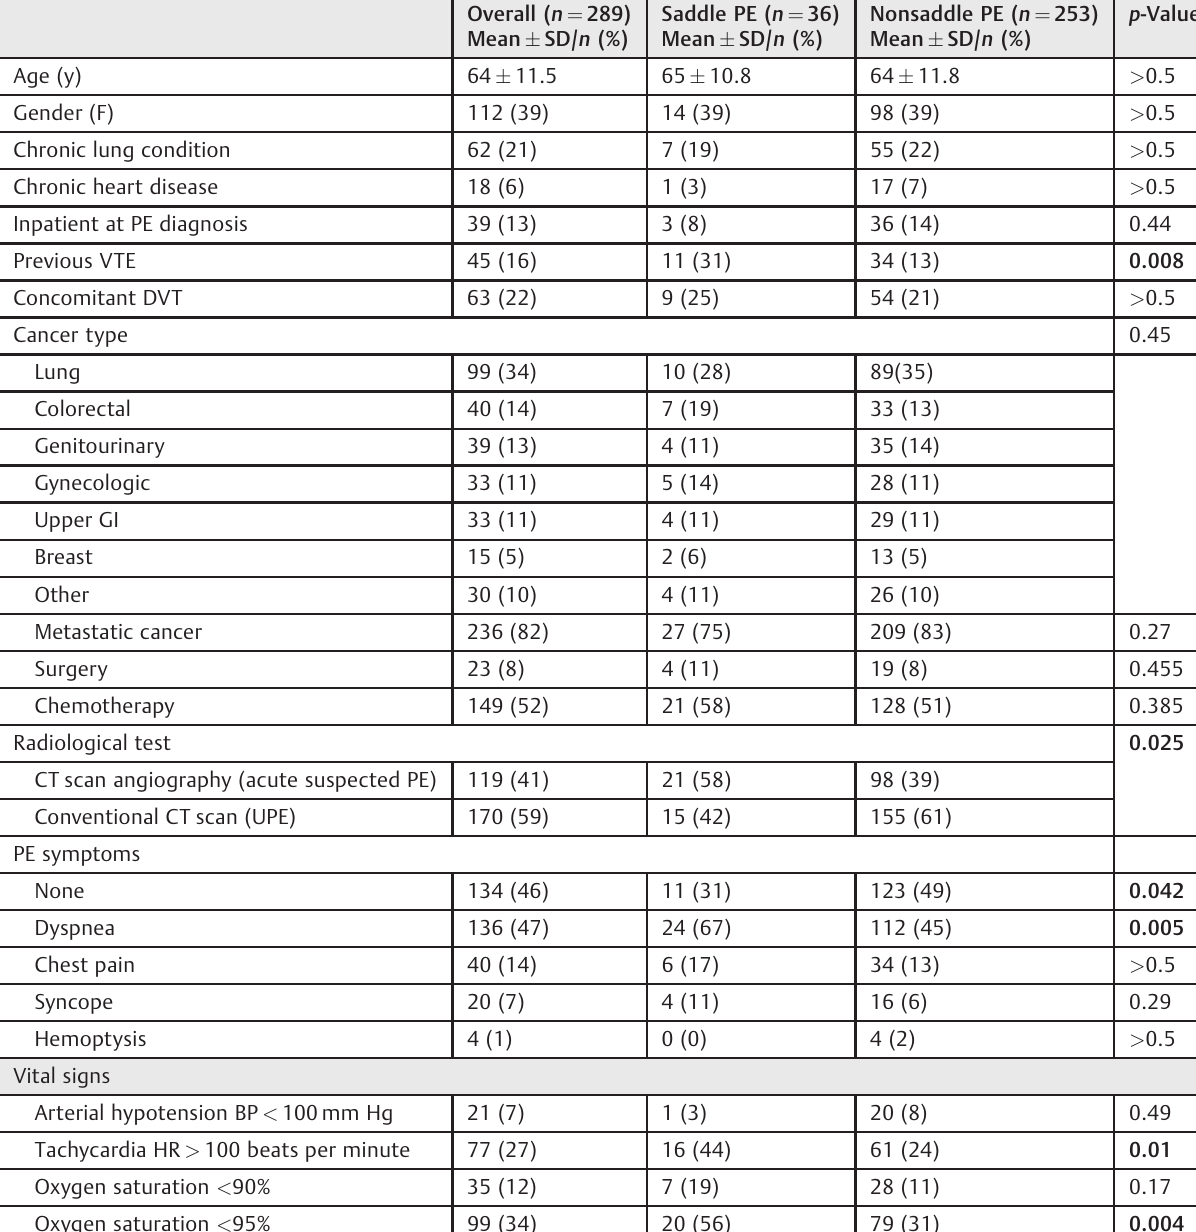
Table 1 Baseline characteristics according to the presence of saddle versus nonsaddle pulmonary